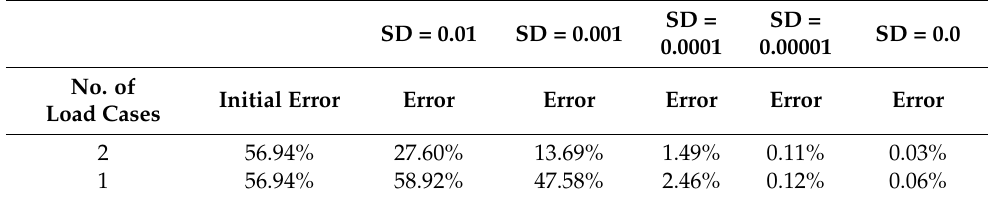
Table 3. Errors obtained for the TMM thermal parameters. Correlation of transient 4 nodes model.